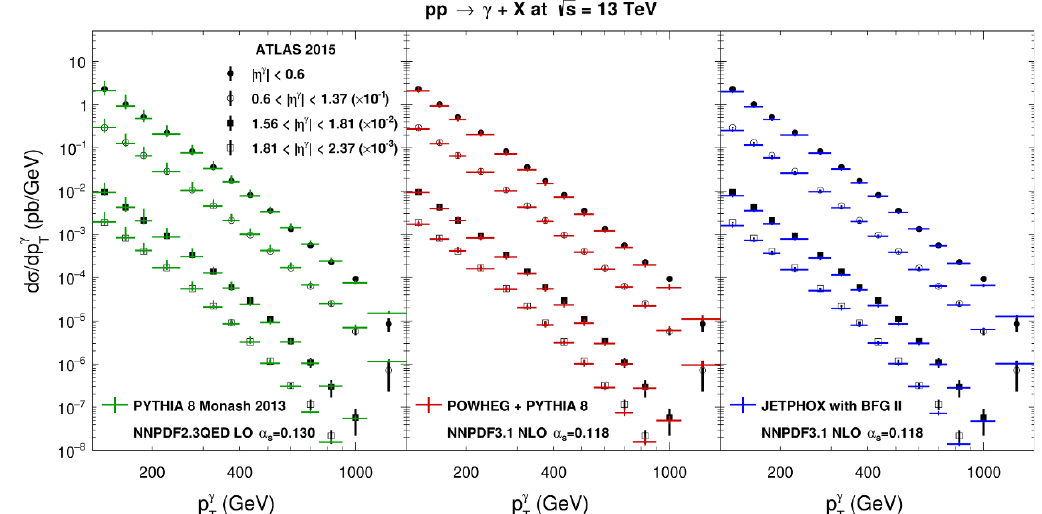
Figure 2 . Transverse momentum distributions of isolated photons in pp collisions at the LHC p with a centre-of-mass energy of s = 13 TeV in four di(cid:11)erent rapidity bins. ATLAS 2015 data are compared to predictions in LO with PYTHIA 8 (left), NLO with JETPHOX (right), and NLO+PS with POWHEG